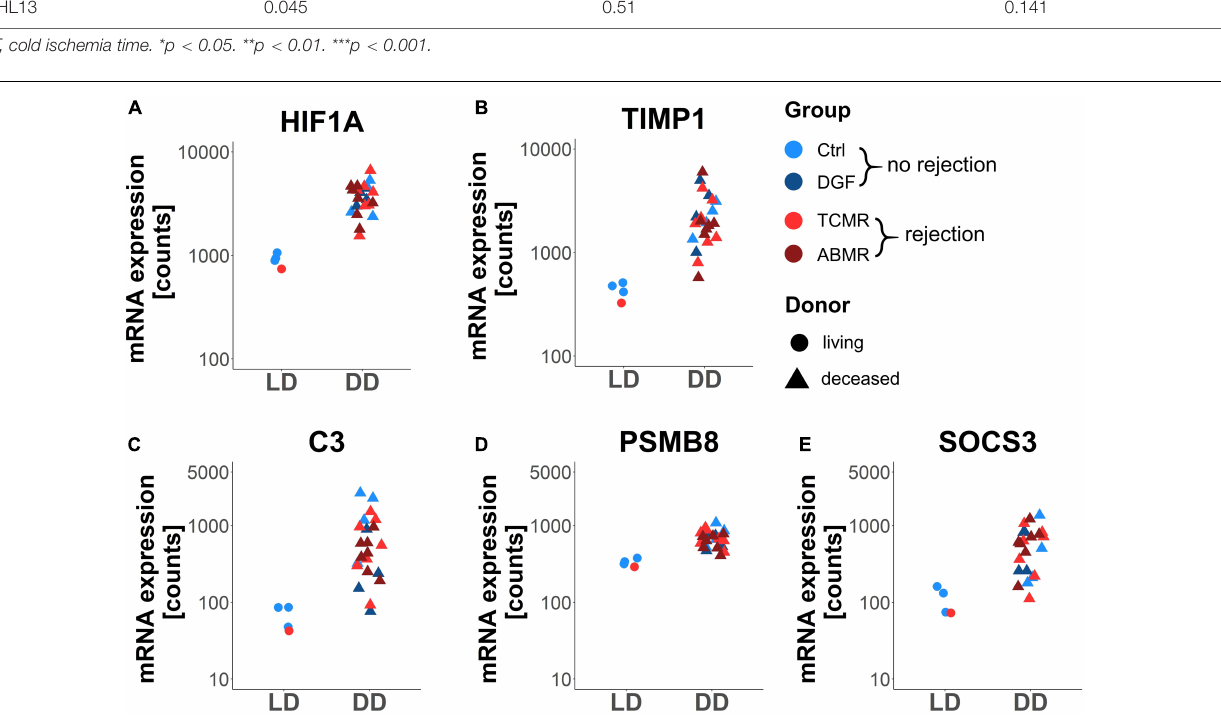
Frontiers in Medicine |